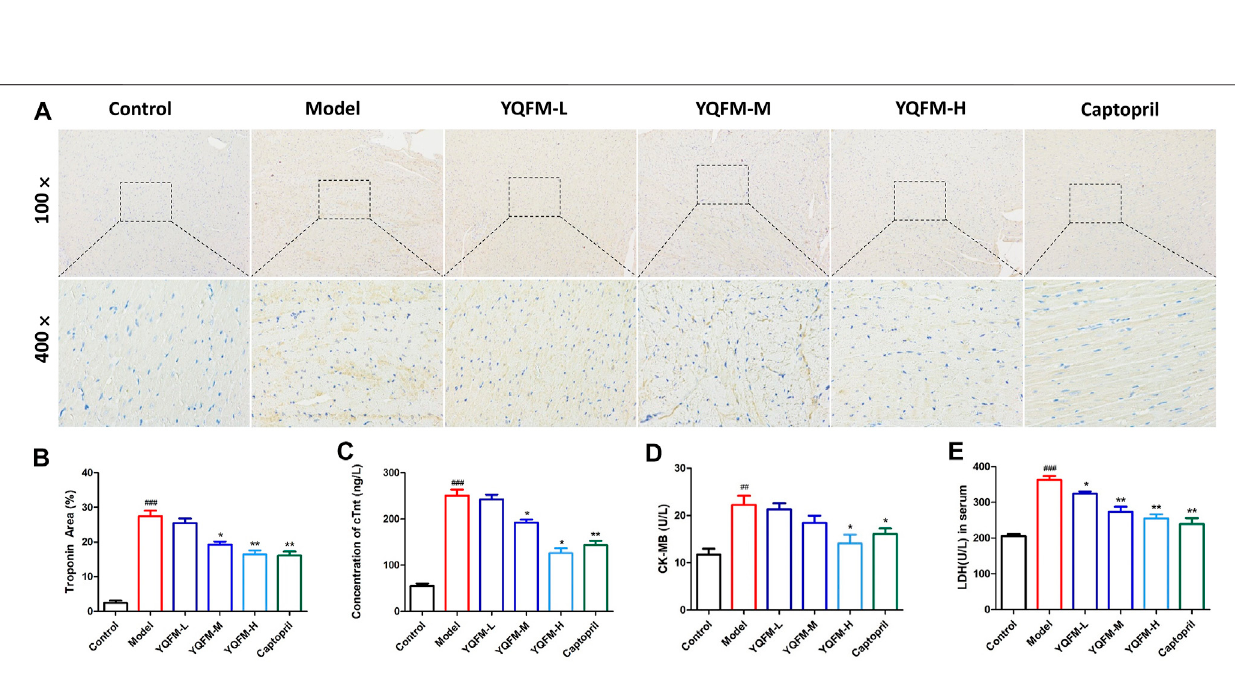
Frontiers in Pharmacology |